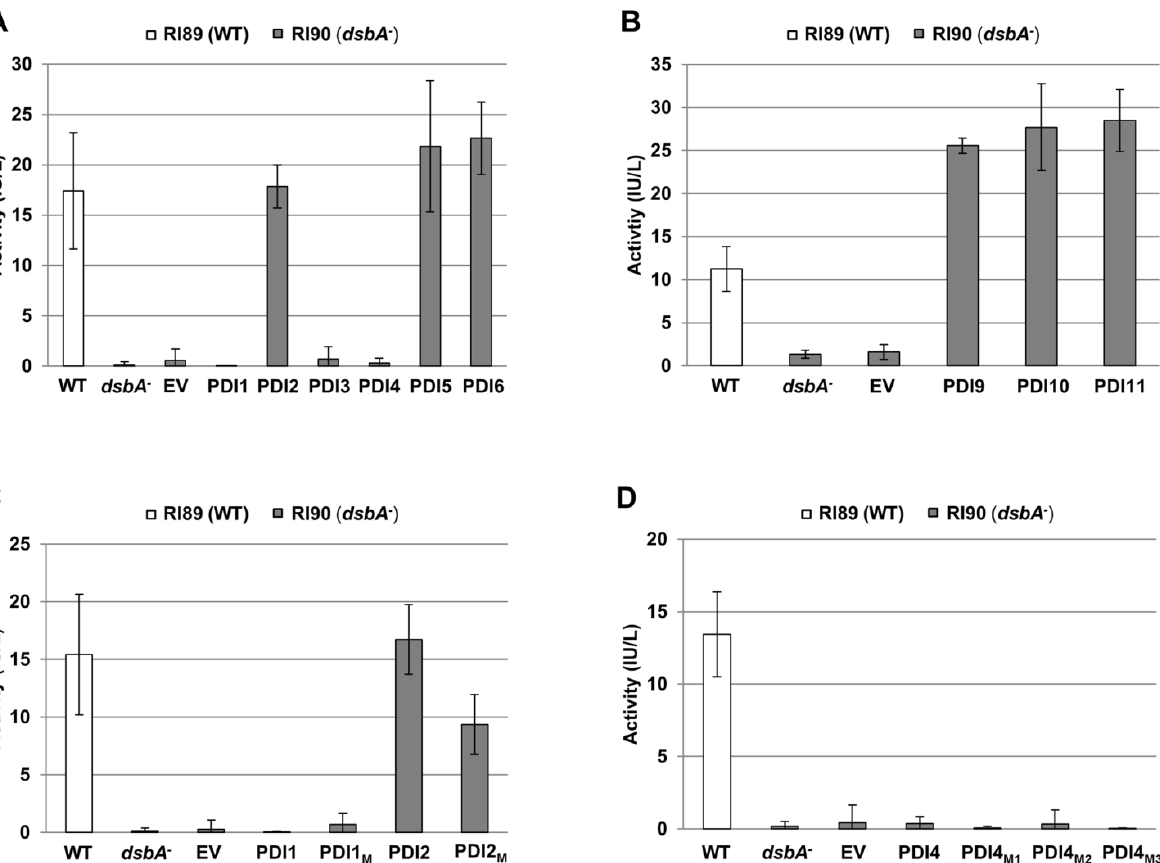
Figure 5. Alkaline phosphatase activity of E. coli dsbA − cells expressing Arabidopsis homologs of PDIA1, PDIA6, and PDI-D. Measured alkaline phosphatase activities of wild-type strain RI89 (WT), dsbA − strain RI90 ( dsbA − ), and RI90 cells transformed with Arabidopsis PDIs: ( A ) PDIA1 subfamily members AtPDI1 through AtPDI6; ( B ) PDIA6 subfamily members AtPDI9 and AtPDI10, and PDI-D subfamily member PDI11; ( C ) ( D ) AtPDI4 and modified variants AtPDI4 ( a : CARC), AtPDI4 ( a : CGHC), and M1 M2 AtPDI4 ( a : CGHC, a′ : CGHC). Error bars represent standard M3